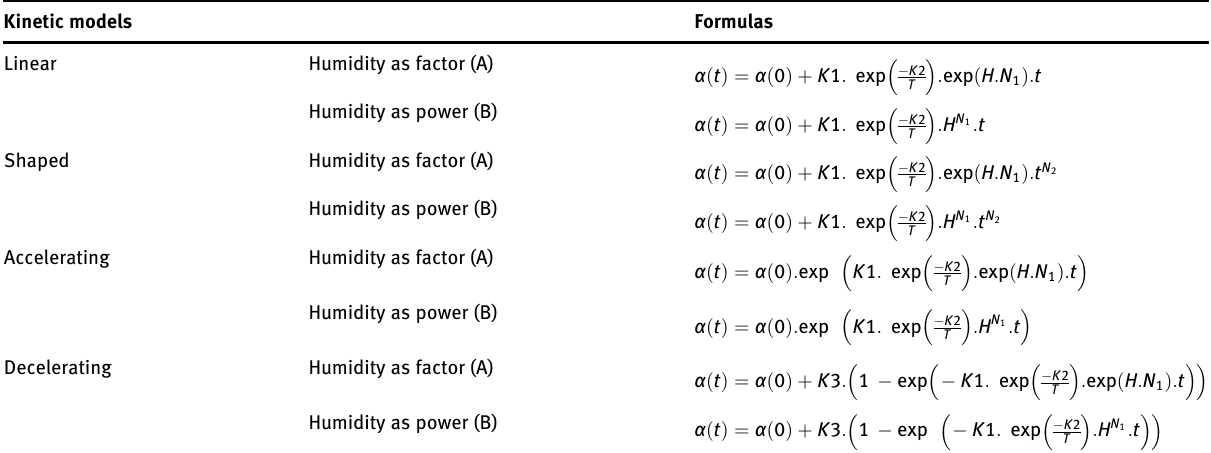
Table  : Mathematical Models used for fi tting experimental data of amoxicillin degradation in normal and accelerated environmental